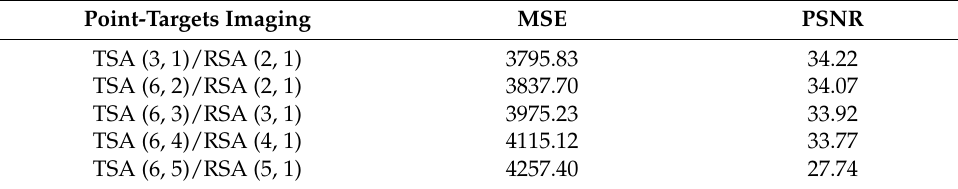
Figure 10. Point targets imaging comparison of . Table 4. Point targets imaging quantitative comparison of